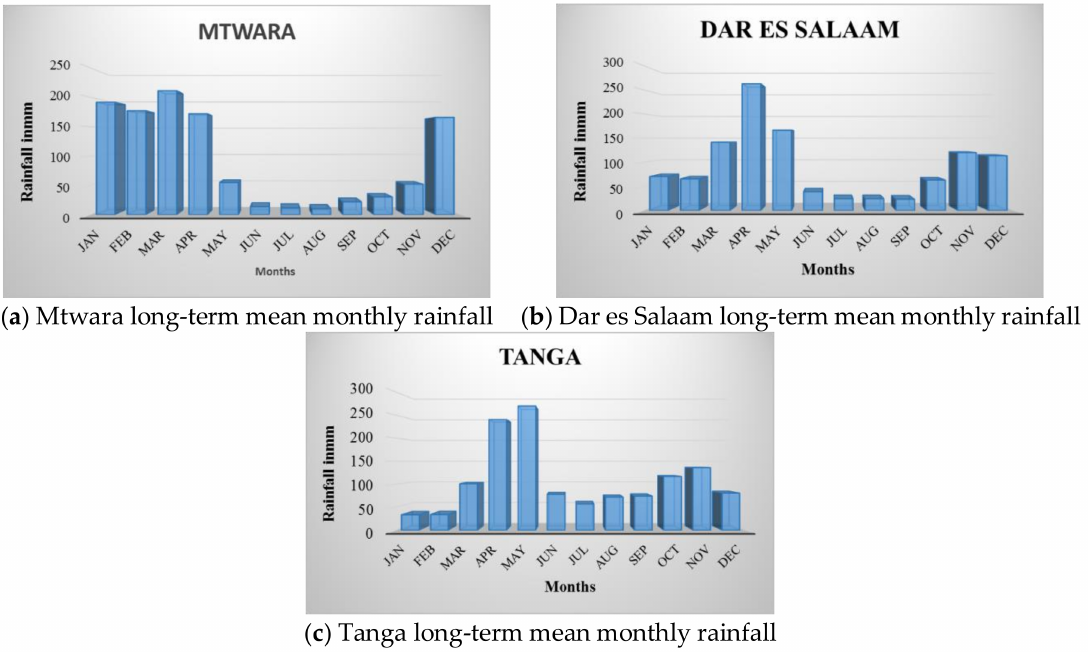
Figure 2. Long-term means of monthly rainfall amount for the three Tanzanian coastal stations, each in a separate geographic region (Mtwara ( a ), Dar es Salaam ( b ), and Tanga ( c